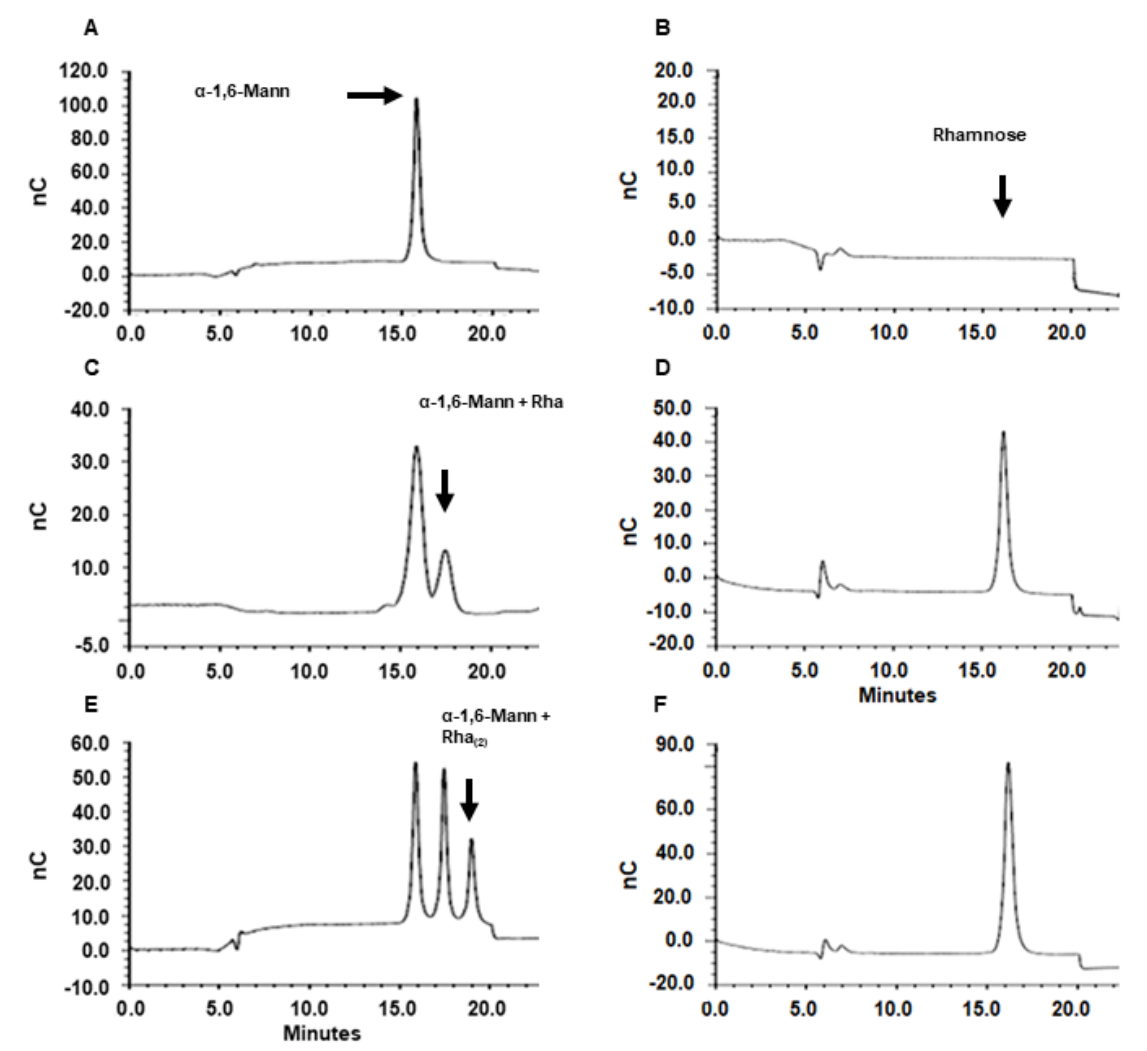
Figure 3. Enzyme activity of recombinant Rht1. Reaction mixtures containing the purified enzyme (100 µ g protein), 200 ng α -1,6-mannobiose, and 500 µ M UDP-L-rhamnose were incubated at 37 ◦ C. After the indicated times, samples were heated in boiling water and analyzed by HPAEC as described in the text. Panels ( A , C , E ) correspond to the incubation times of 0 min, 30 min, and 3 h, respectively. The enzyme product was treated with 1 U α -L-rhamnosidase for 60 min, and the monosaccharides released were analyzed by HPAEC. Panels ( B , D , F ) correspond to monosaccharides released from enzyme products obtained at the incubation times of 0 min, 30 min, and 3 h, respectively. The analysis under the curve allowed us to generate quantitative data from these assays, and we found that rRht1 and rRht2 showed a specific activity of 198.7 ± 34.4 and 215.4 ± 28.6 µ g trisaccharide min − 1 mg protein − 1 (Table 3). Mock reactions with no sugar donor or with bacterial extract subjected to the same purification procedure gave threshold values (Table 3). In addition, the enzyme activity was minimal when the heat-denatured enzyme was included in the reactions (Table 3). Next, to assess the specificity of the enzyme for the sugar donor, UDP-rhamnose was substituted by equimolar concentrations of UDP- glucose, GDP-mannose, UDP-N-acetylglucosamine, and UDP-galactose. None of these molecules were recognized by rRht1 or rRht2 as sugar donors in the enzyme reaction (Table 3), suggesting that both enzymes are specific for